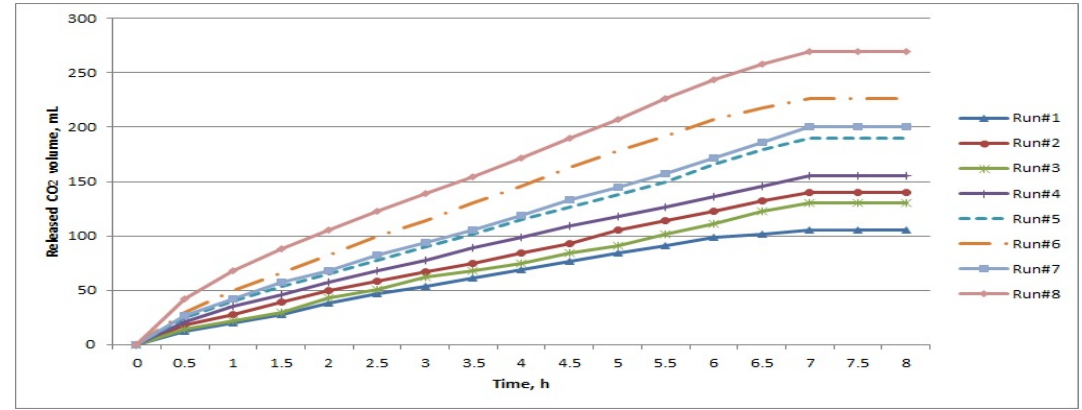
Figure 2. The CO 2 volume released and accumulated during fermentation vs. time. (run # 1, run # 2,…, run # 8 represent the 8 samples from experimental matrix, Table 2).